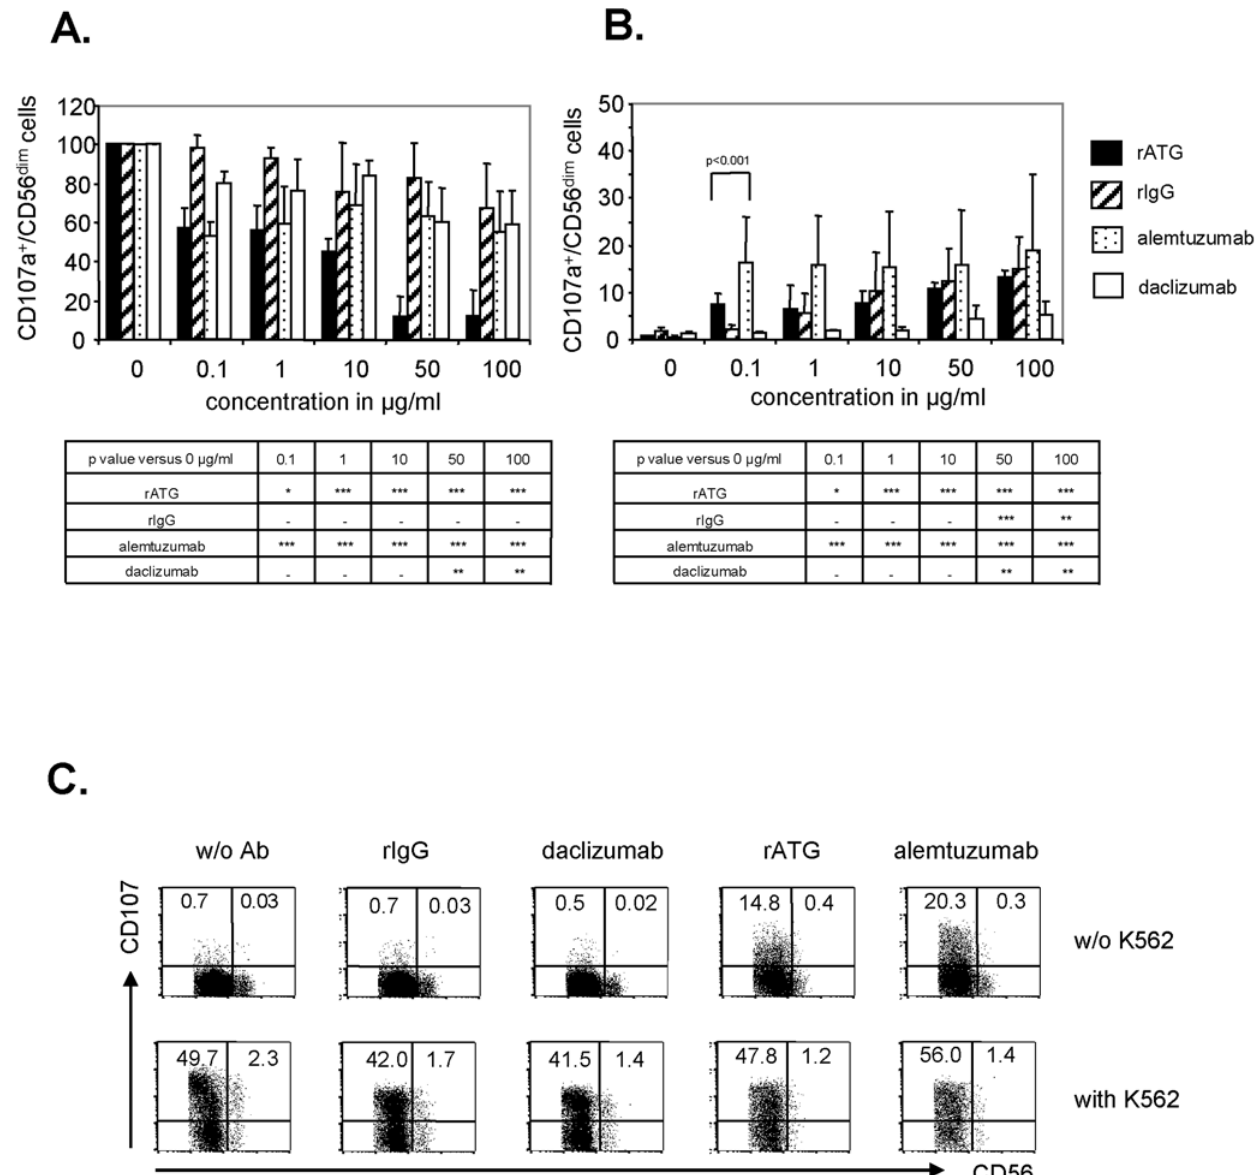
Figure 4. Rabbit ATG and alemtuzumab influence the degranulation of peripheral blood CD3 2 CD56 dim NK cells. (A) K562 cells (E/T ratio 2:1) and CD107a antibody were added to NK cells cultured with IL-2 (200 IU/ml) and varying concentrations of rATG, alemtuzumab, daclizumab and rIgG. NK cells were harvested and stained for CD3 and CD56. For analysis the percentage of CD107a + NK cells of controls (without K562) was subtracted from the CD107a + NK cells co-incubated with K562 cells. Values demonstrate CD107a expression on CD56 dim NK cells normalized to untreated cells, which were set at 100%. Results are displayed as means 6 SD for 5 independent experiments. Asterisks (*) indicate values that showed significantly less degranulation compared to untreated controls: *p , 0.05, ** p , 0.01, *** p , 0.001. (B) A degranulation assay was performed (A) without the addition of K562 cells. Results are displayed as the mean of CD107a + cells on CD56 dim NK cells 6 SD (n=5). Asterisks (*) indicate values that showed significantly higher degranulation compared to untreated controls: *p , 0.05, ** p , 0.01, *** p , 0.001. (C) Representative FACS dot plots of CD56 + CD3 2 NK cells stained for CD107a. Treatment with 0.1 m g/ml rATG and alemtuzumab produced a higher induction of CD107a in CD56 dim NK cells compared to 0.1 m g/ml daclizumab and